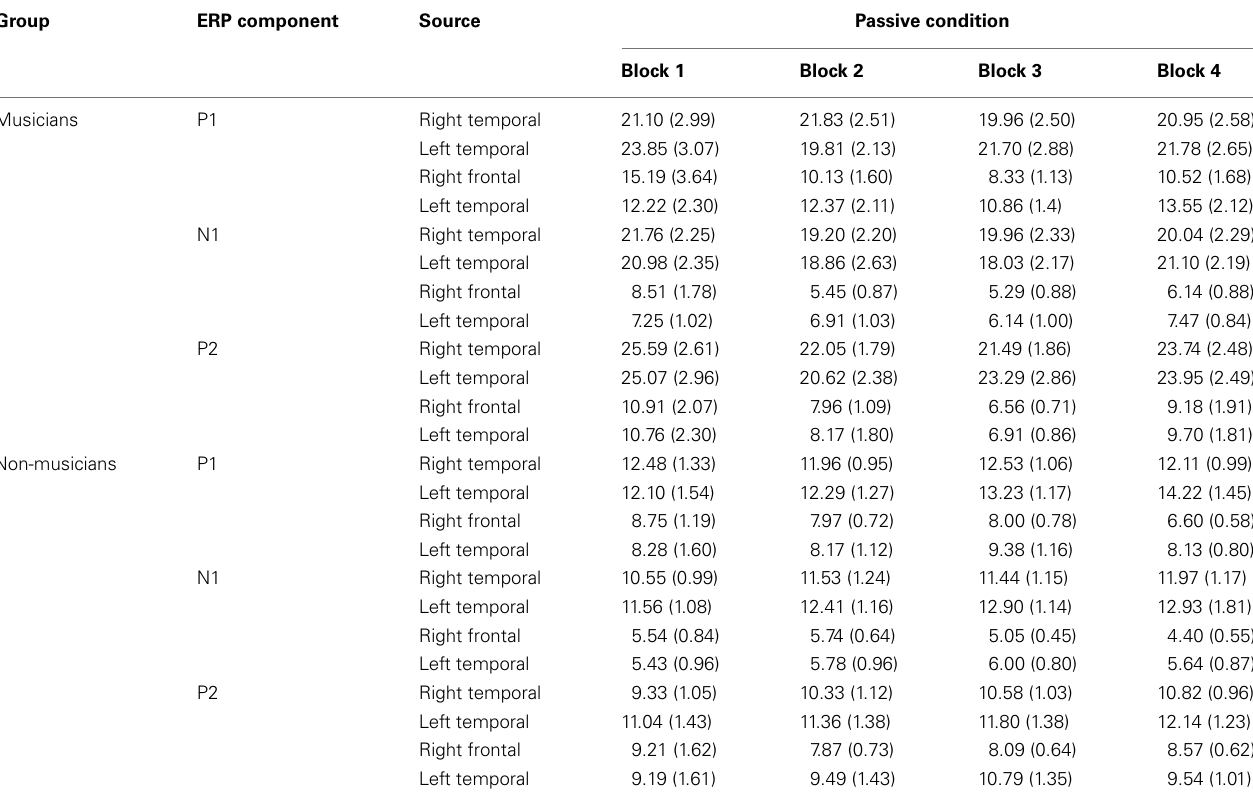
TableA1 | P1, N1, and P2 source magnitude mean amplitudes (nAm) and SEs of the means (in parentheses) for the standard stimuli from nose-referenced grand